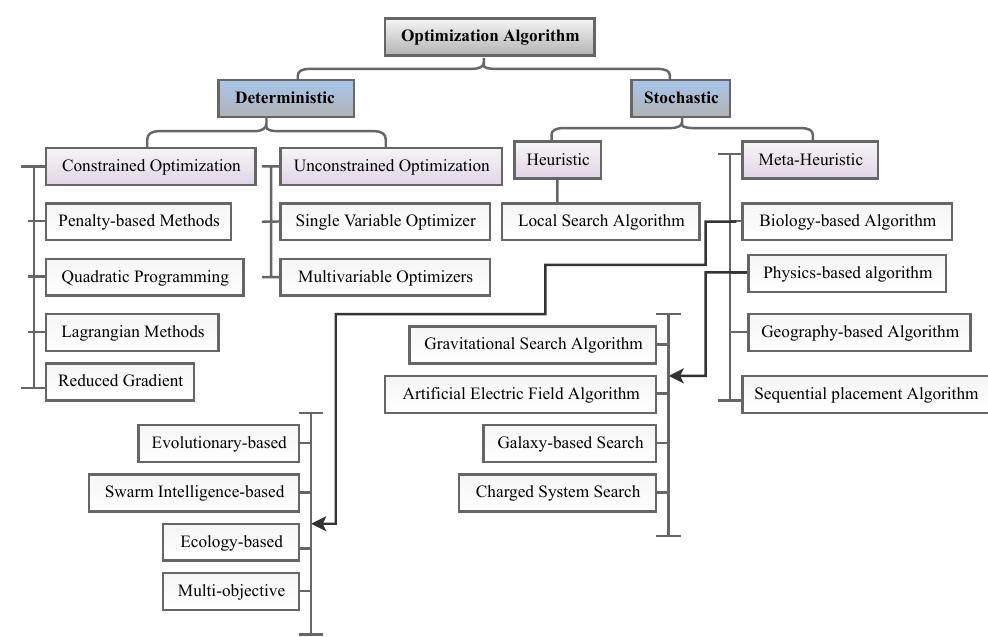
Figure 9. Classification of optimization